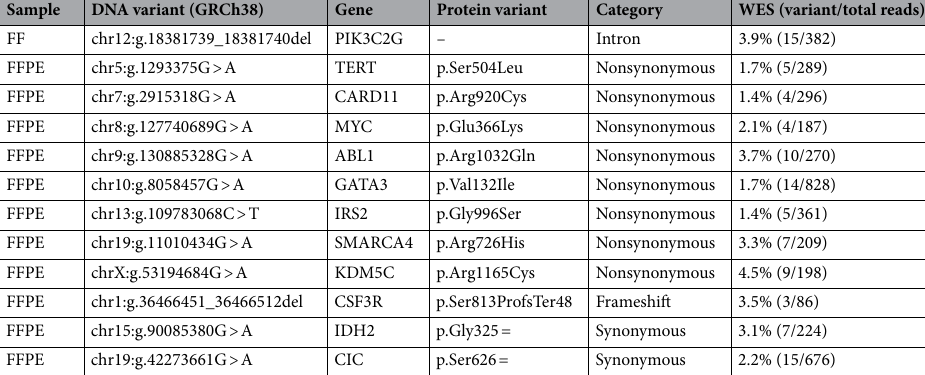
Table 2. WES-detected low-level variants in cancer-related genes confirmed by blocker displacement amplification (BDA).